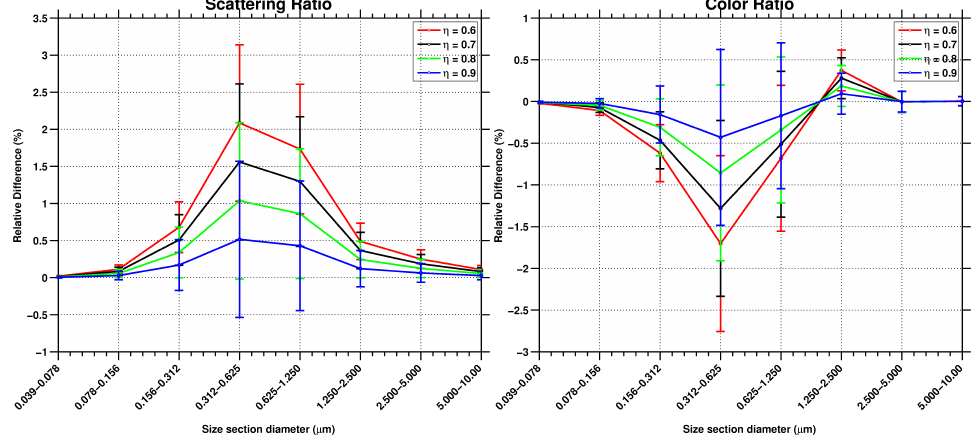
Fig. 5. Profiles of attenuated scattering ratio ( R 0 ) and color ratio ( χ 0 ) for BCAR (left) and DUST (right) per size section as a function of altitude.